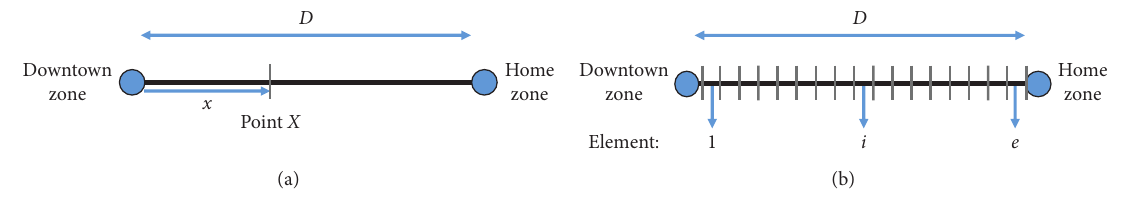
Figure 2: (a) Two zone city and (b) two zone city with the corridor divided into e